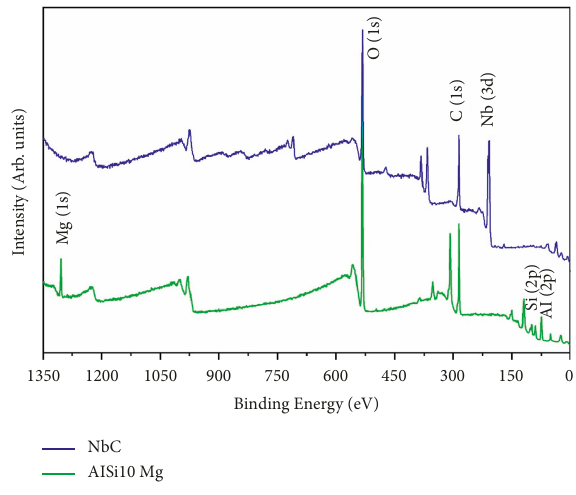
Figure 2: XPS spectra of AlSi10Mg and NbC. Table 1: Input parameters and their levels for regular mixing.